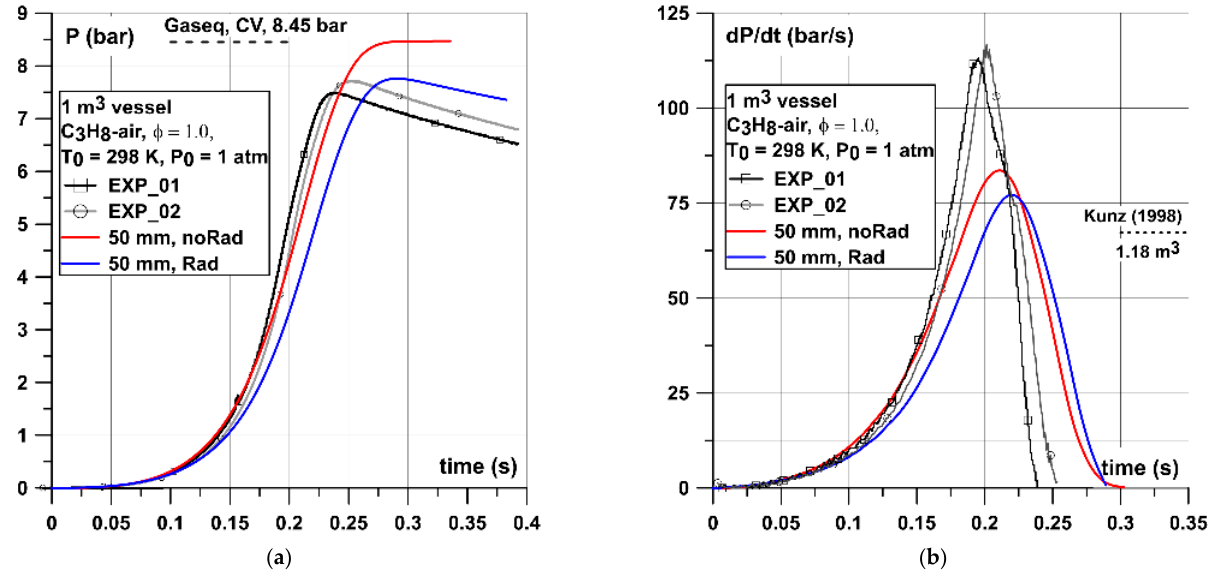
Figure 16. ( a ) Pressure and ( b ) dP/dt graphs for stoichiometric C 3 H 8 –air mixture in the 1 m 3 vessel. Dotted line mark (dp/dt) max value provided by Kunz [40] in the vessel of a similar volume and shape.